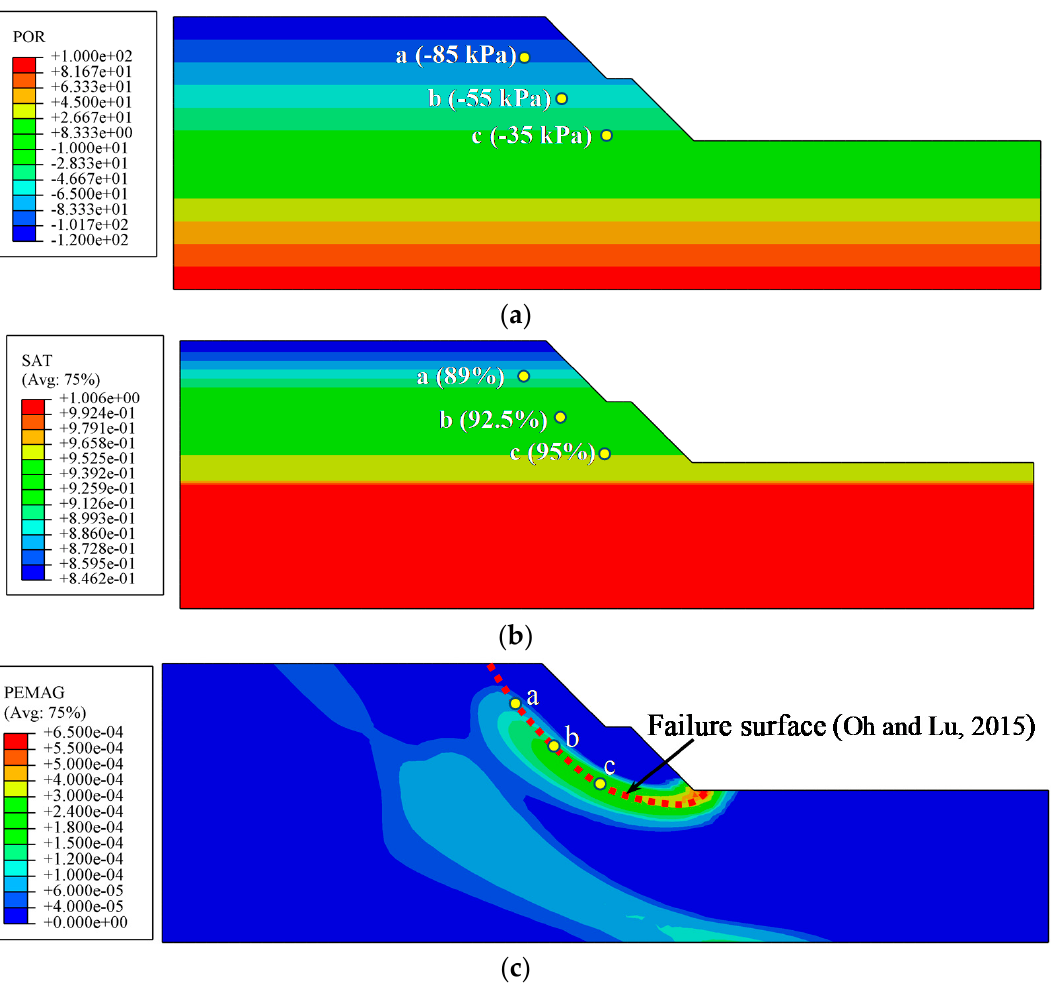
Figure 7. Simulated results on 1 April 2011 at Pohang site: ( a ) the pore-water pressure, PWP (unit: kPa); ( b ) the degree of saturation ( S r ); and ( c ) the potential slide surface.